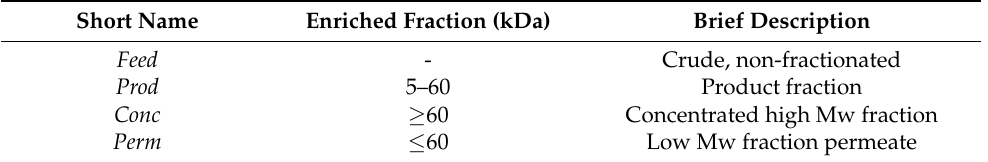
Table 1. Lignosulfonate